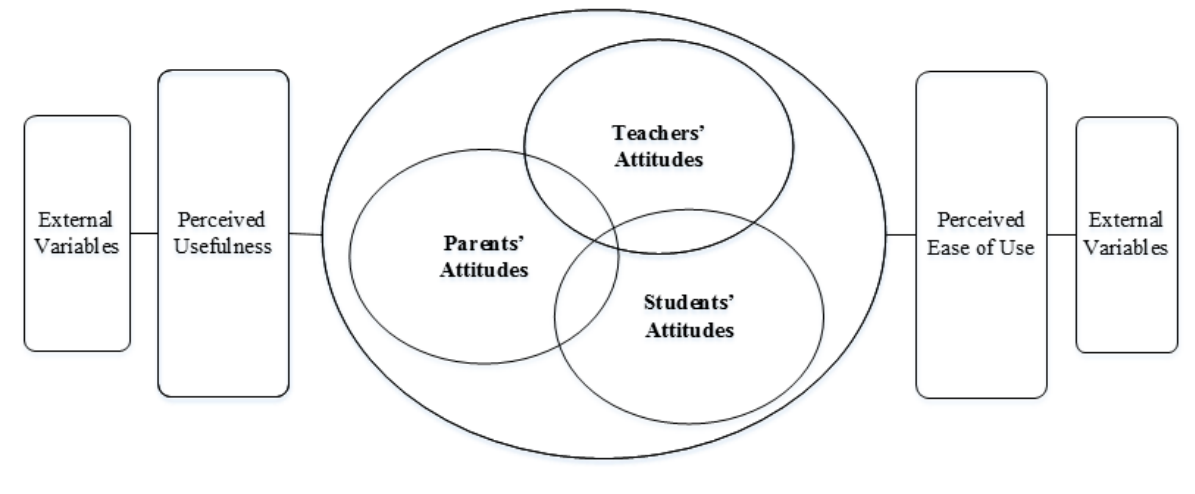
Figure 1. Framework for educational technology implementation in